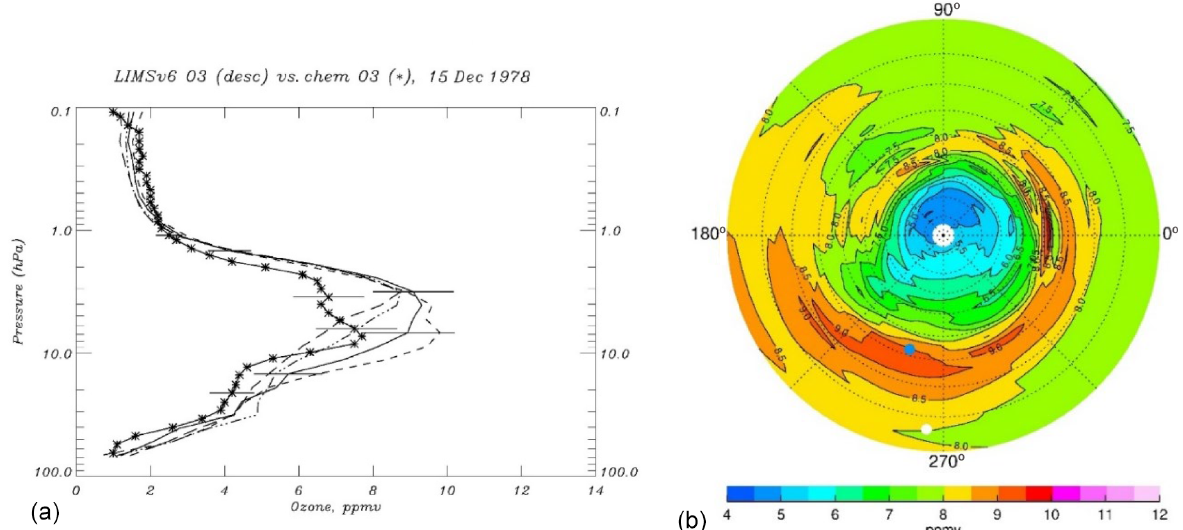
Figure 4. (a) Profiles of V6 ozone (at 06:11Z) versus rocket chem ozone (* at 05:41Z) on 15 December. The four V6 profiles have separations of 2.6 ◦ latitude, and the solid curve (at 31.8 ◦ N) is closest to White Sands (WS, 32.4 ◦ N). Horizontal bars are ozone errors. (b) NH V6 ozone at 4.6hPa; Greenwich (0 ◦ E) is on the right, and CI is 0.5ppmv. Latitude (dotted circles) is every 10 ◦ . Satellite location is the white dot (6 ◦ N, 265 ◦ E), and WS is the blue dot.